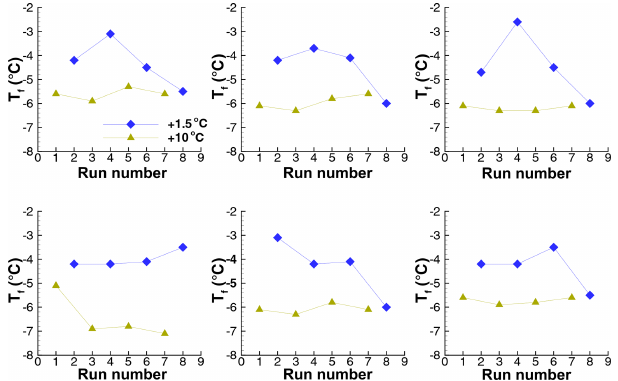
Figure 16. Sequences of freezing temperatures for drop numbers 67, 68, 73, 77, 90, and 96 in Exp. H.